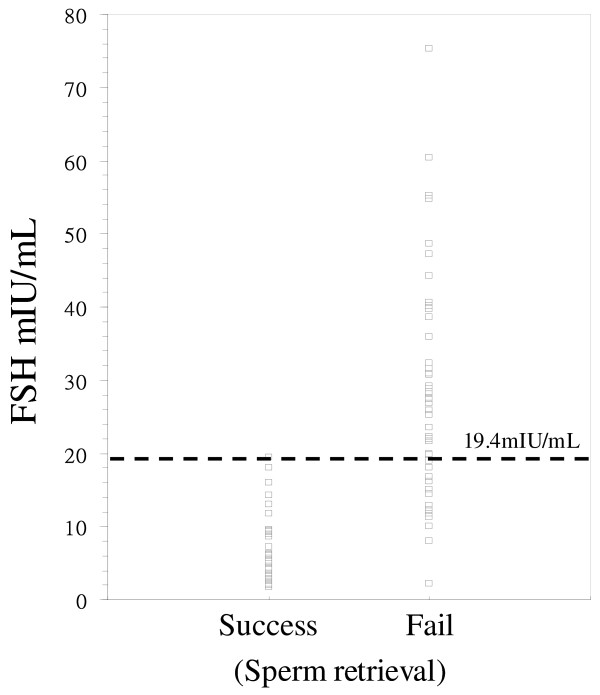
Dot diagram shows the serum FSH data and the cut-off point for sperm retrieval. Dot diagram shows the serum follicle-stimulating hormone data and the cut-off point for sperm retrieval. The best cut-off point for failed sperm retrieval in non-obstructive azoospermic patients is 19.4 mIU/mL. However, a value of FSH lower than 19.4 mIU/mL does not predict normal spermatogenesis and successful sperm retrieval.